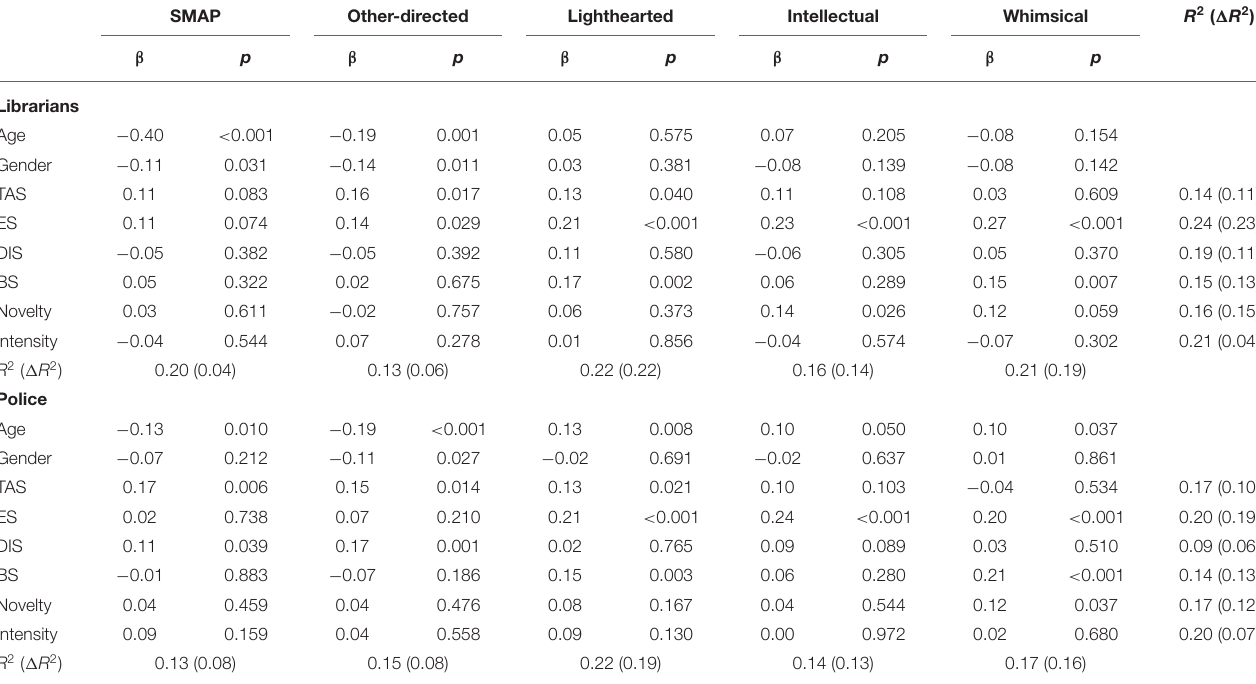
TABLE 5 | Regression analyses predicting playfulness by sensation seeking facets of the SSS and AISS. SMAP Other-directed Lighthearted Intellectual Whimsical R 2 ( 1 R 2